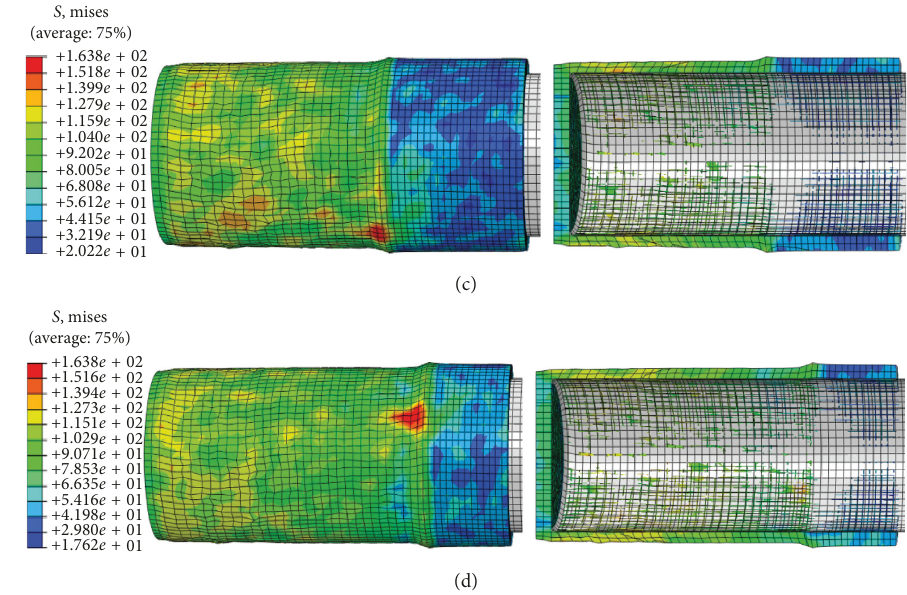
Figure 11: Third-pass equivalent stress distribution. (a) 25%. (b) 50%. (c) 75%. (d)